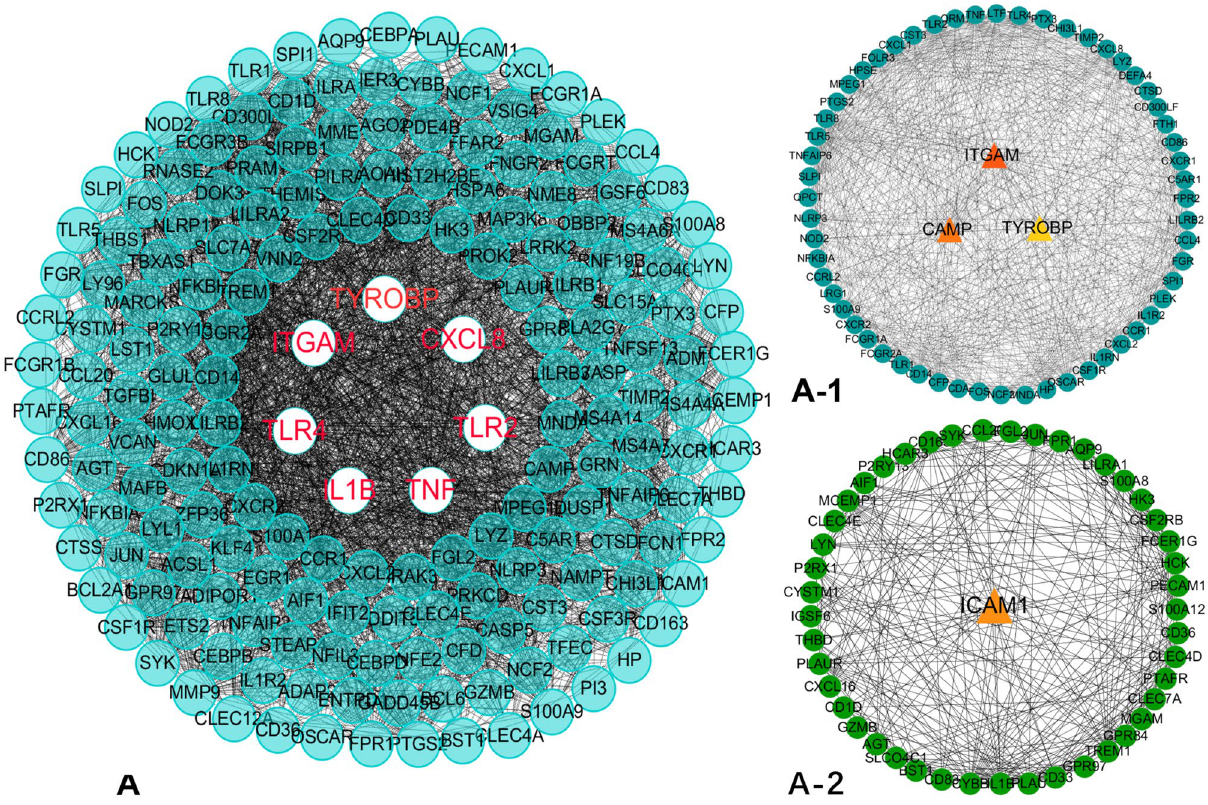
Figure 6. PPI network construction and identification of hub genes. ( A ) PPI network of genes in magenta module. The edge shows the interaction between two genes. Significant modules identified from the PPI network using the MCODE with a score > 6.0. ( A-1 ) Molecular-1 with MCODE score = 26.2. ( A-2 ) Molecular-2 with MCODE score = 13.4.